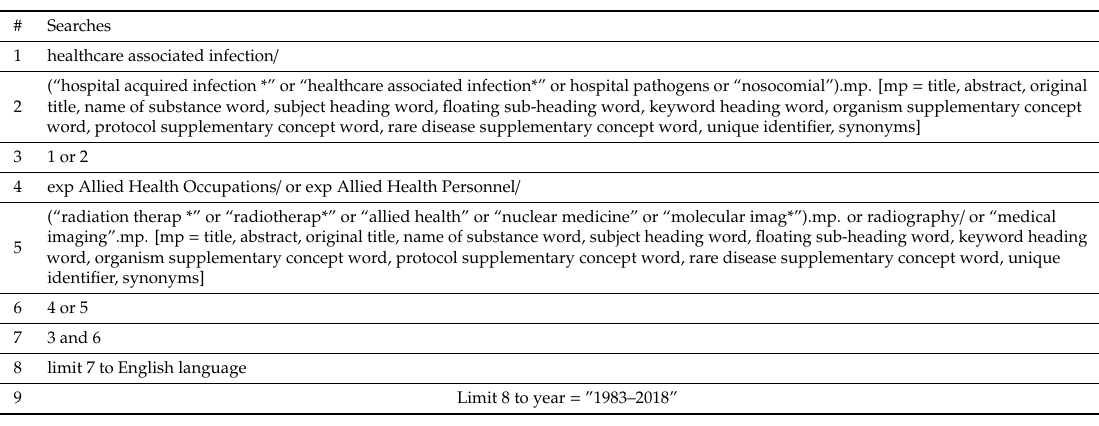
Table 1. The search strategy performed in one of the five databases (Medical Literature Analysis and Retrieval System Online;